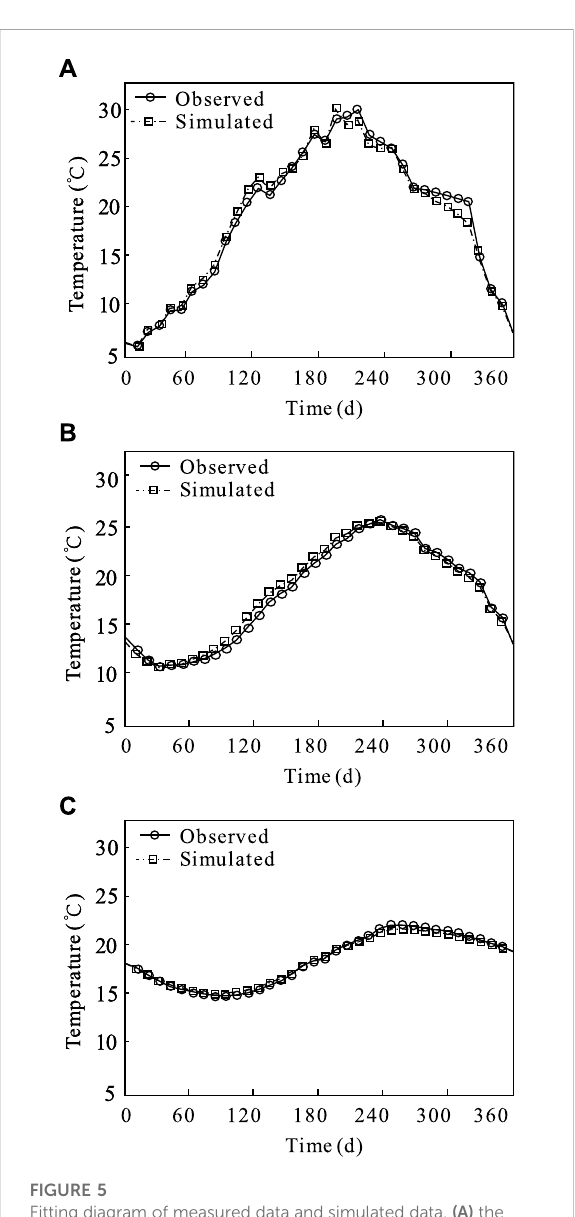
FIGURE 5 Fitting diagram of measured data and simulated data. (A) the buried depth is 40 cm, (B) the buried depth is 160 cm and (C) the buried depth is 320 cm.